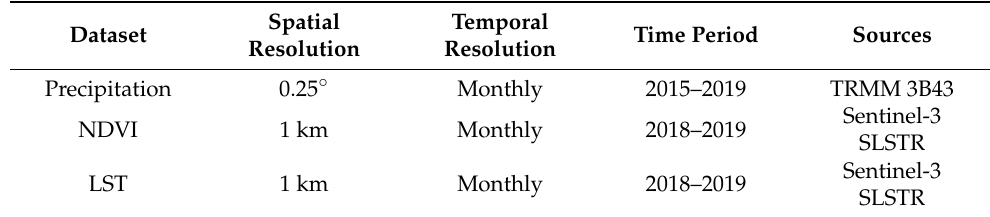
Table 1. Data information in this